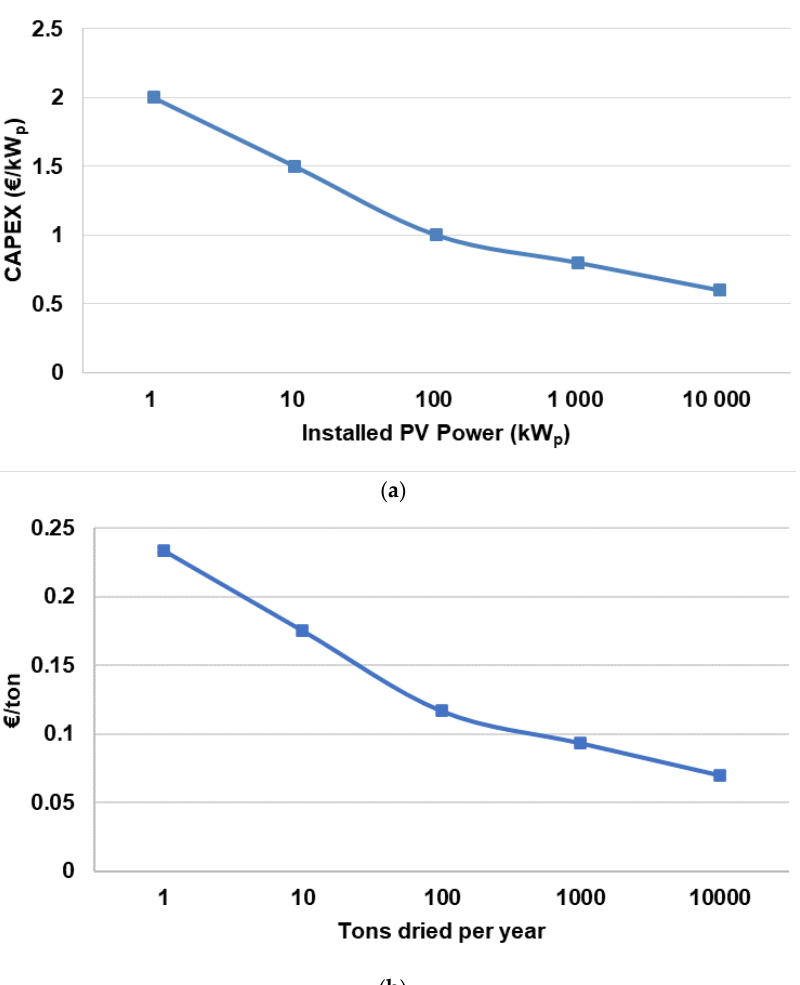
Figure 2. Unit cost per unit of installed PV power ( a ) and per ton of dried alfalfa ( b ) for different system sizes, from a small scale (1 kW p ) to a large scale (10 MW p ).